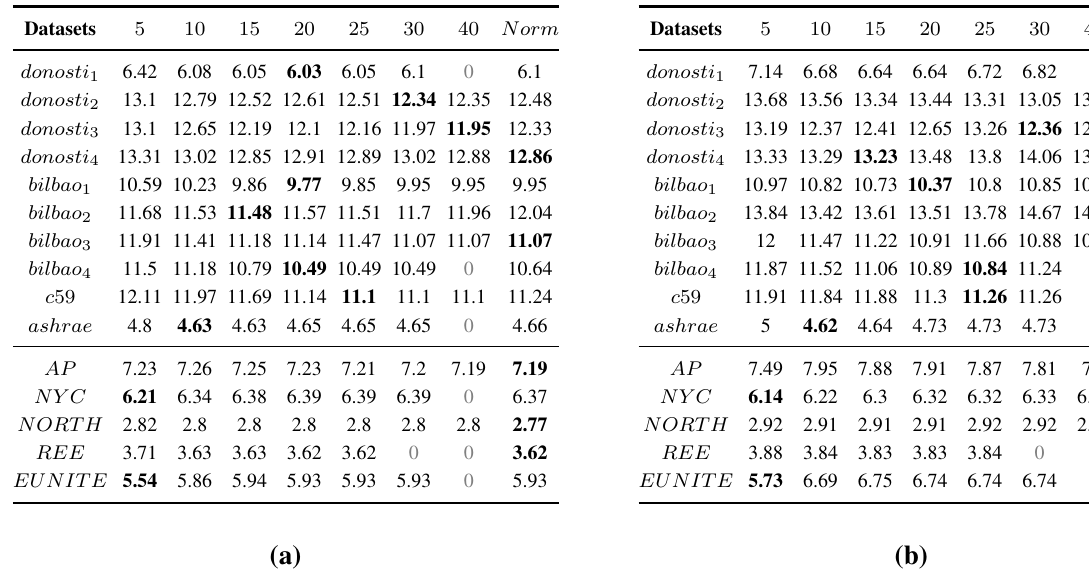
Table 3. MAPE result for the whole dataset (%). Columns represent the type and the value of the threshold k . The last column has the results without the post-process method. Bold results denote the best results; grey, the absence of anomalous day on that threshold. ( a ) MAPE results of the AR model forecasting (%); ( b ) MAPE result of the SVM model forecasting (%).